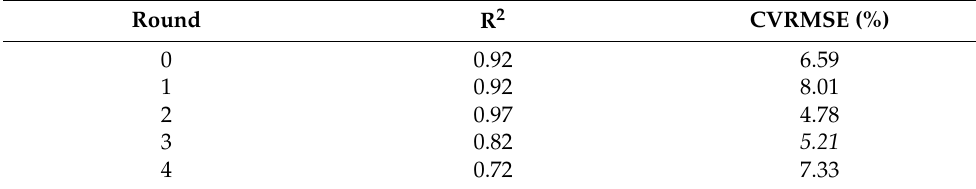
Table 6. R 2 and CVRMSE (%) values on the submission period for the combined result.